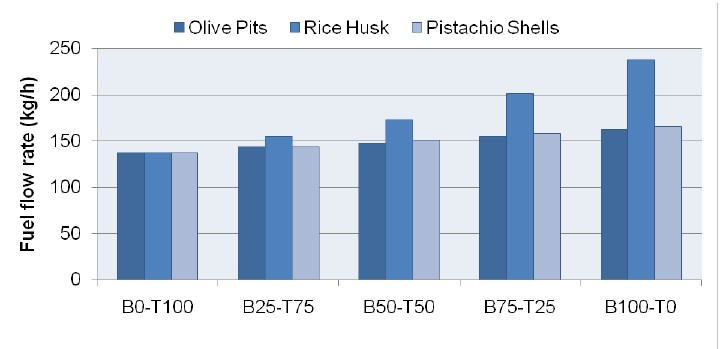
Fig. 2. Variation of fuel flow rate of the system with different blends of Tunçbilek coal and biomass